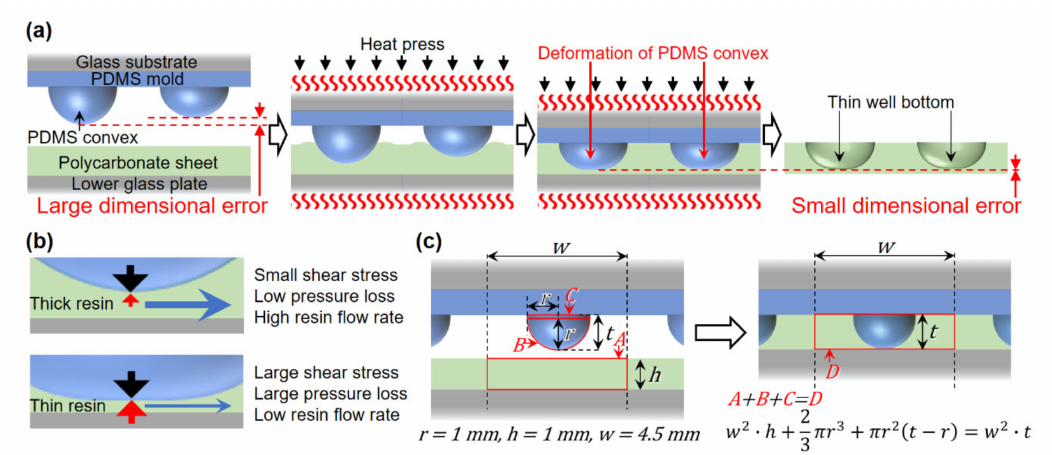
Figure 1. Facile fabrication of thin-bottoms of round wells. ( a ) Scheme for fabrication of the wells by heat-press molding, based on the deformation of a polymethylsiloxane (PDMS) convex. ( b ) Principal for the fabrication of thin well bottoms with a small dimensional error based on the resin flow dynamics. ( c ) Design of the PDMS